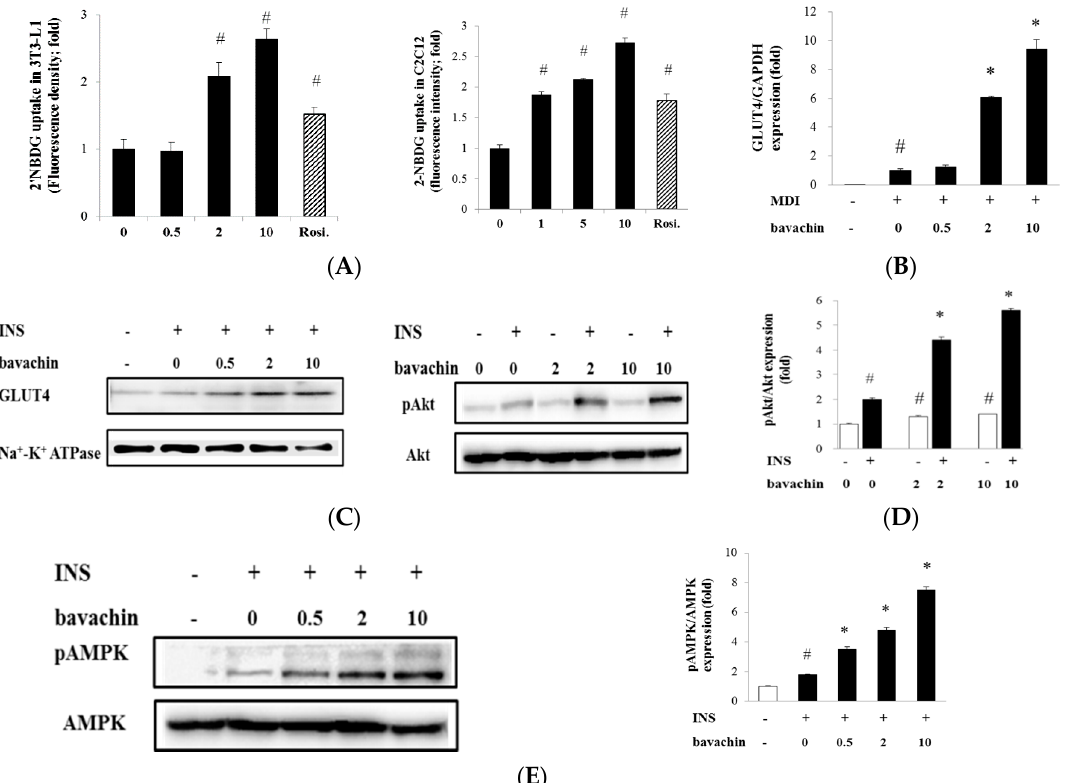
Figure 4. The effect of bavachin on insulin and AMPK signaling pathway-mediated glucose uptake: ( A ) the effect of bavachin on insulin-stimulated glucose uptake in differentiated adipocytes and myoblasts. Differentiated 3T3-L1 adipocytes ( left panel) and C2C12 myoblasts ( right panel) were serum-starved and then exposed to bavachin (0.5, 2 and 10 µM for adipocytes, 1, 5 and 10 nM for myoblasts) for 24 h. After 1 h incubation of insulin (100 nM), the cultures were incubated with 2-( N -(7-nitrobenz-2-oxa-1,3-diazol-4-yl) amino)-2-deoxyglucose (2-NBDG) labeling-medium for 1 h. Fluorescence retained in the cell monolayer was measured with excitation wavelength at 465 nm and emission wavelength at 540 nm. Data are expressed as mean ± SD. # p < 0.001 vs. insulin alone; ( B ) Effect of bavachin on the mRNA expression and translocation of GLUT4 in differentiated adipocyte. Gene expression level of GLUT4 was determined by qPCR as described above; ( C ) To detect the GLUT4 translocation, 3T3-L1 pre-adipocytes were pre-incubated for 1 h with bavachin and followed by insulin stimulation for a further 1 h. The plasma membrane fraction was prepared using an ultracentrifugation; The effect of bavachin on the phosphorylation of Akt ( D ) and AMPK ( E ) in adipocytes. 3T3-L1 pre-adipocytes were pre-treated for 1 h with bavachin prior to insulin (100 nM) for 1 h. Protein blots were incubated with phospho-Akt or phospho-AMPK antibody. Data are expressed as mean ± SD. # p < 0.01 vs. control; * p < 0.001 vs. insulin (INS).